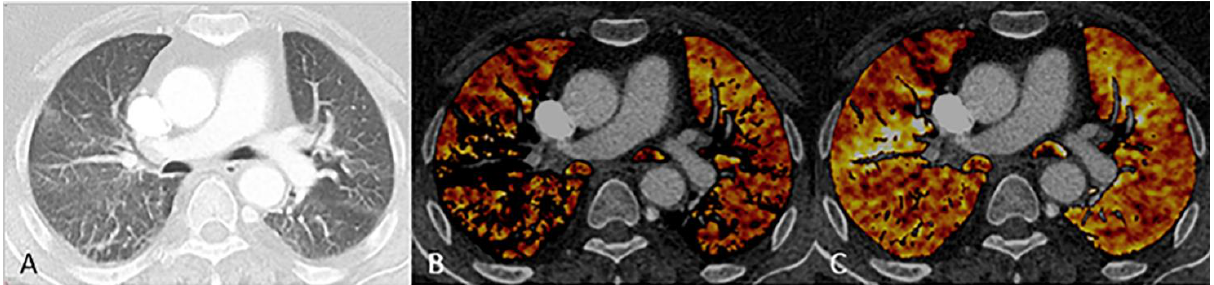
Figure 2. Technique of perfusion blood volume (PDV) image reconstruction: 66-year-old female from the reference group (aDE—pulmonary arterial Dual Energy CT) with chronic pulmonary arterial embolism. ( A ) conventional reconstruction, ( B ) incomplete lung segmentation due to increased density of the lung parenchyma above the upper threshold (−600 HU), and ( C ) full segmentation of the lung parenchyma after adapting the upper threshold to –300 HU. Both PBV images are displayed in the same window (width 80 HU, center 40 HU).